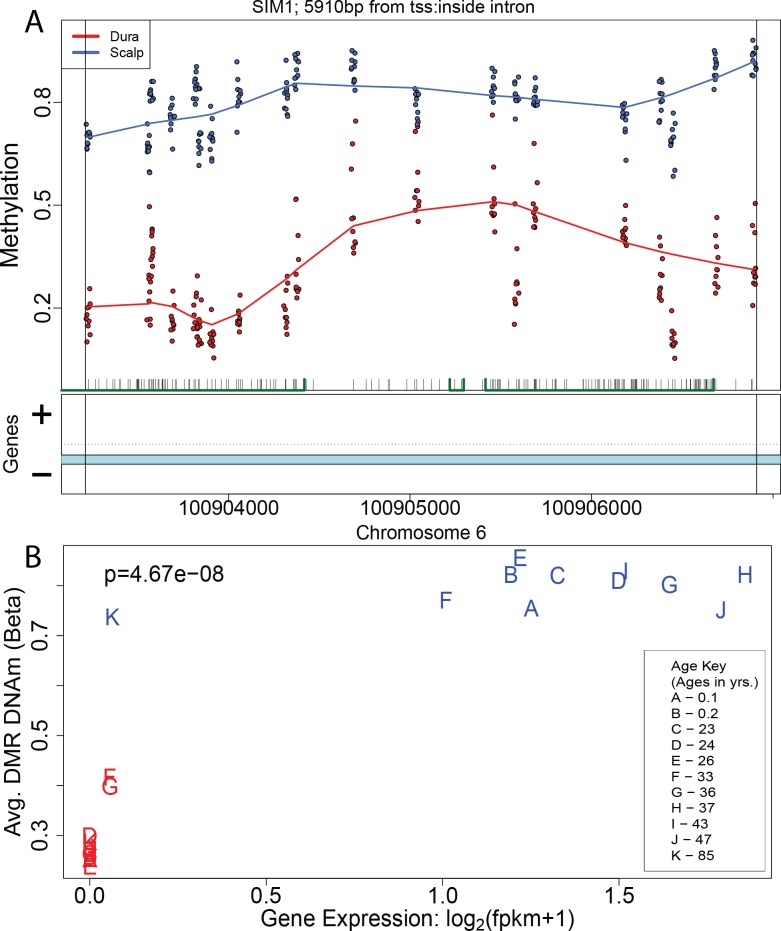
Regional DNA methylation changes manifest in the transcriptome.(A) Plot of the DNAm levels (proportion methylation) of an example significant DMR, which overlaps the gene SIM1. (B) Plot of the average DMR DNAm levels versus the expression level of SIM1, showing high positive correlation (p = 4.67x10−8).